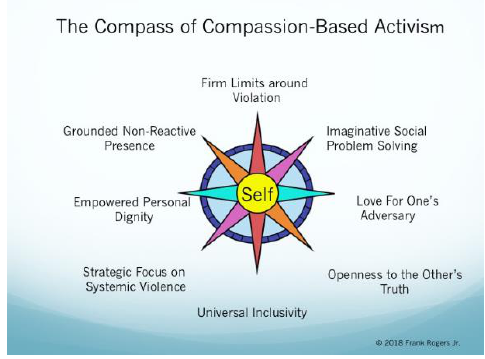
Figure 1. The Compass of Compassion-Based Activism created by Frank Rogers, Jr.